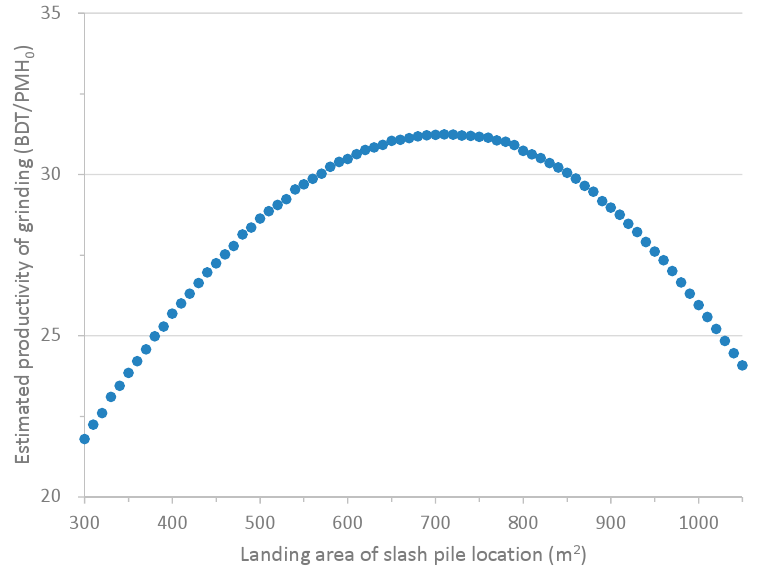
Figure 6. Relationship between the landing area of slash pile location and the estimated productivity of grinding.